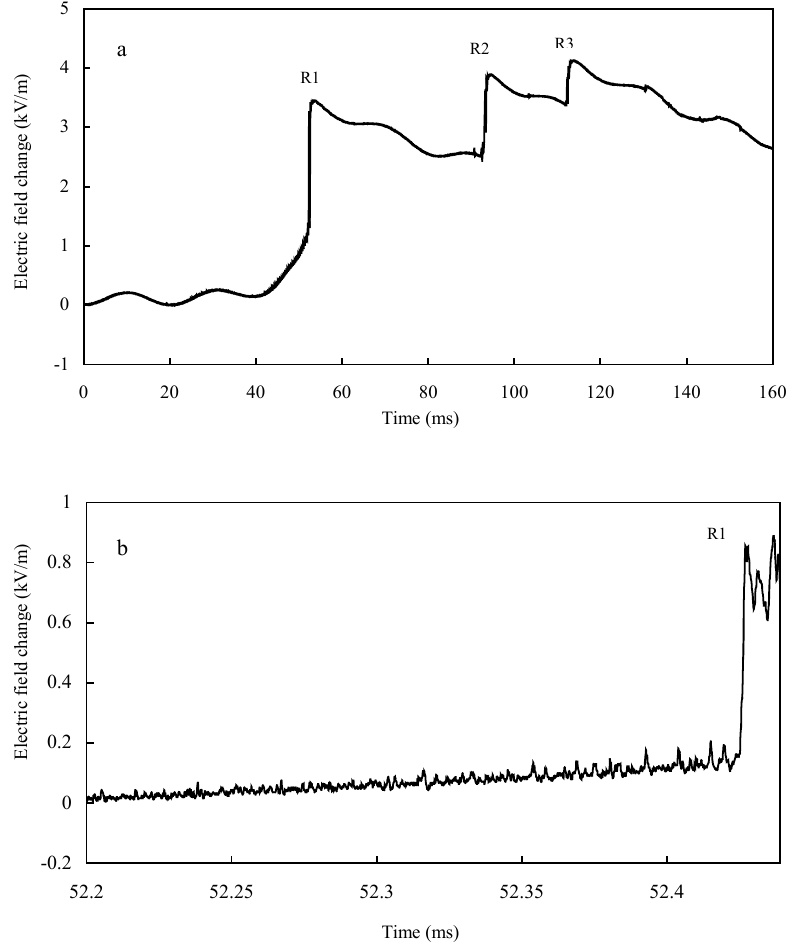
Fig. 1. Electric field produced by a negative CG lightning discharge that occurred at 12:33:44 (Beijing time) on 25 July 1999 by using the wideband slow antenna system. (a) for about 160ms time scale, (b) time expanded electric field change about 250 µ s just before R